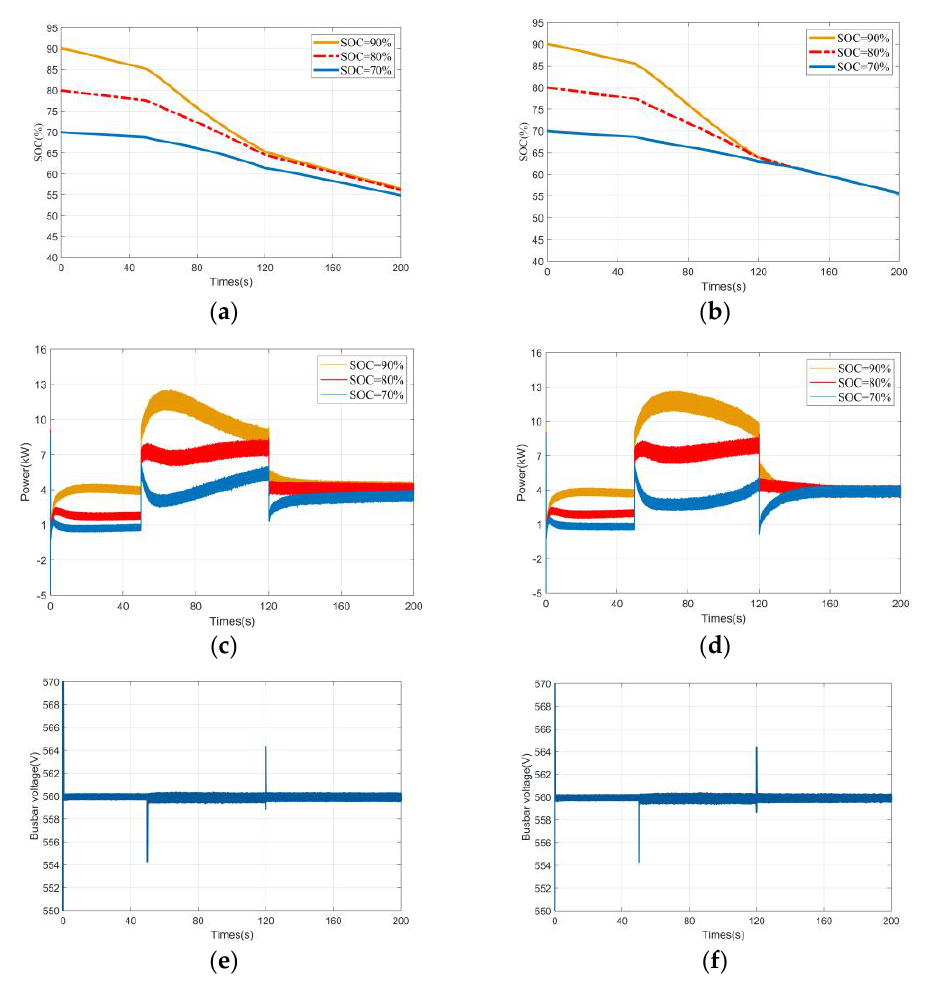
Figure 15. Simulation waveform of discharge under load and FC power variation. ( a ) SOC sag control, lithium battery SOC waveform; ( b ) improved SOC sag control, lithium battery SOC waveform; ( c ) SOC sag control, lithium battery power waveform; ( d ) improved SOC sag control, lithium battery power waveform; ( e ) SOC sag control, bus voltage waveform; ( f ) improved SOC sag control, bus voltage waveform.